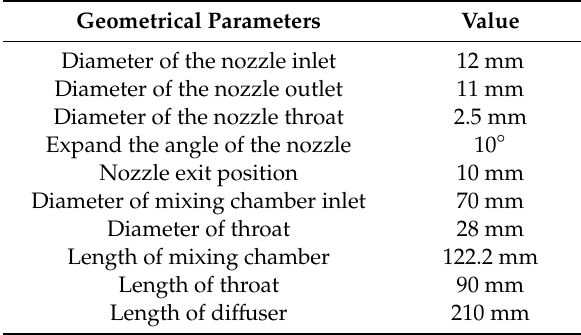
Table 2. Flow conditions of the steam